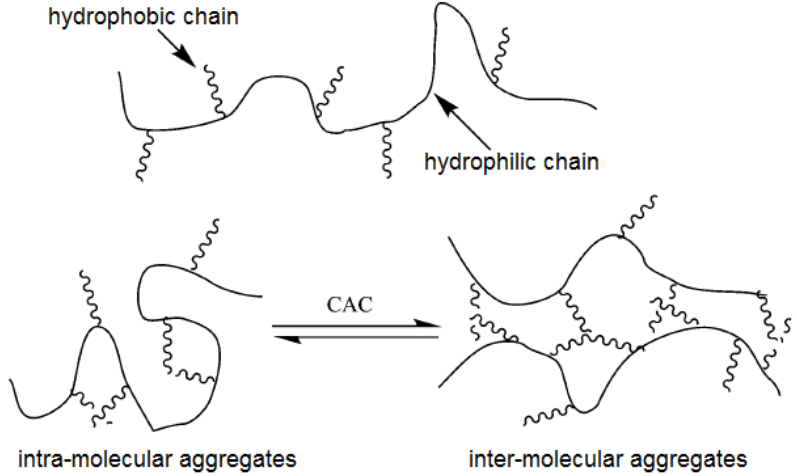
Figure 4. Intra- and inter-molecular associations in a hydrophobically modified polyacrylamide. Adapted with permission from [216].